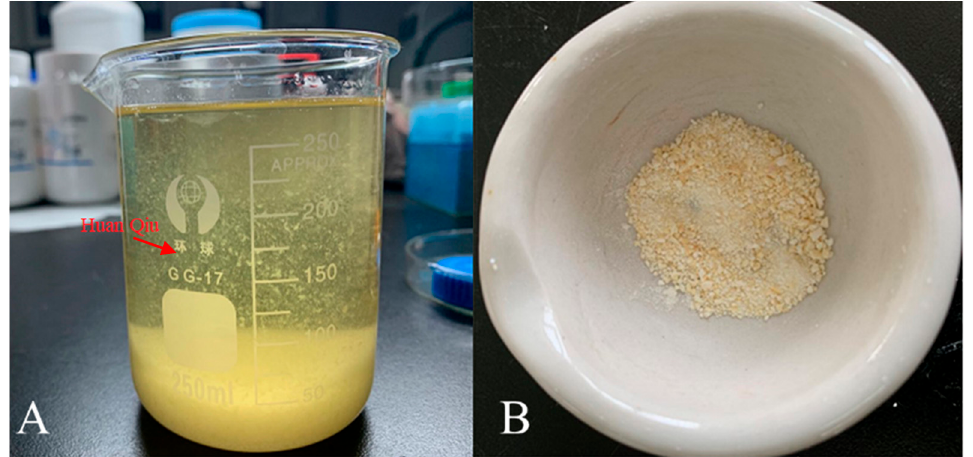
Figure 1. Washing and drying of flocculated products. ( A ) Flocculant washing process; ( B ) flocculant after drying.